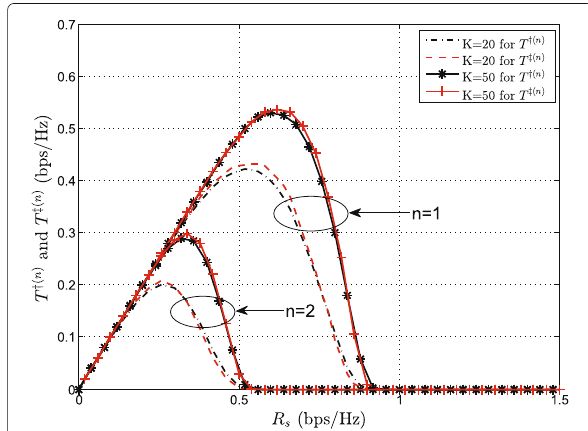
Fig. 7 Simulation results of multi-user diversity impacts on EST for suboptimal scheme and optimal scheme on basis of SNR = 3 dB